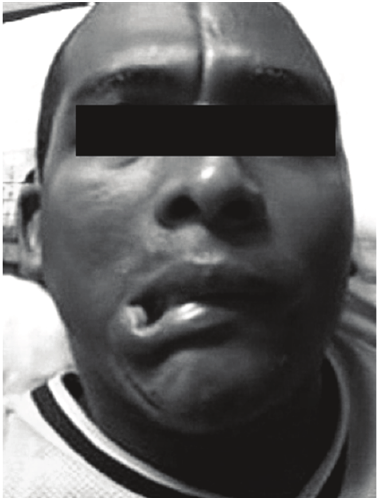
Figure 1: Atrophic and hyperpigmented band of sclerotic skin over frontal scalp and retraction of right cigomatic and depressor labii inferioris